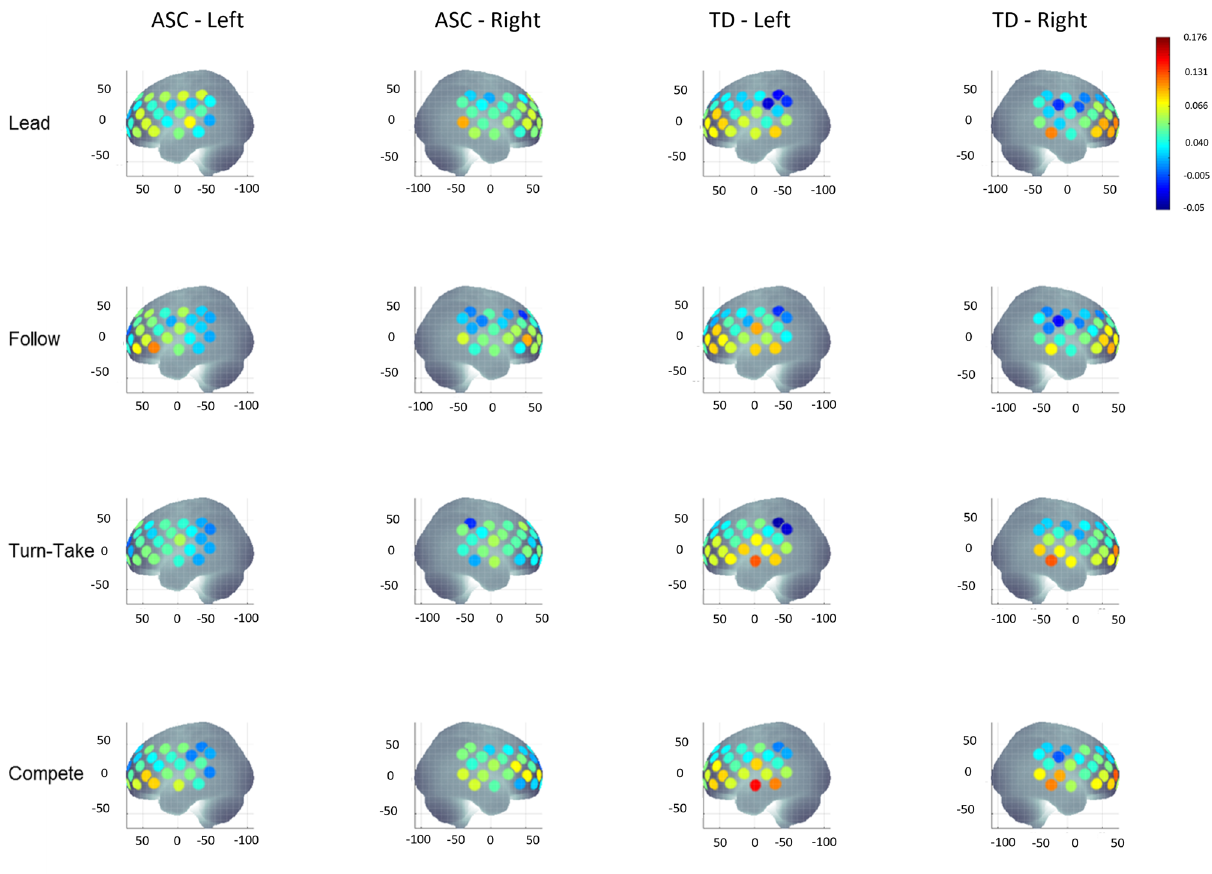
Figure 2. A visual representation of averaged HbO 2 concentration during Lead, Follow, Turn-take, and Compete conditions in children with an ASC and TD children. HbO 2 values on Y-axis range from − 0.05 indicated by blue to 0.176 indicated by red. TD children showed greater STS-related channel activation during Compete and Turn-take conditions compared to that of children with an ASC. In contrast, children with an ASC had greater activation in IPL channels during the Lead, Turn-Take, and Compete. This figure was made in MATLAB (version 2021b, https:// www. mathw orks.